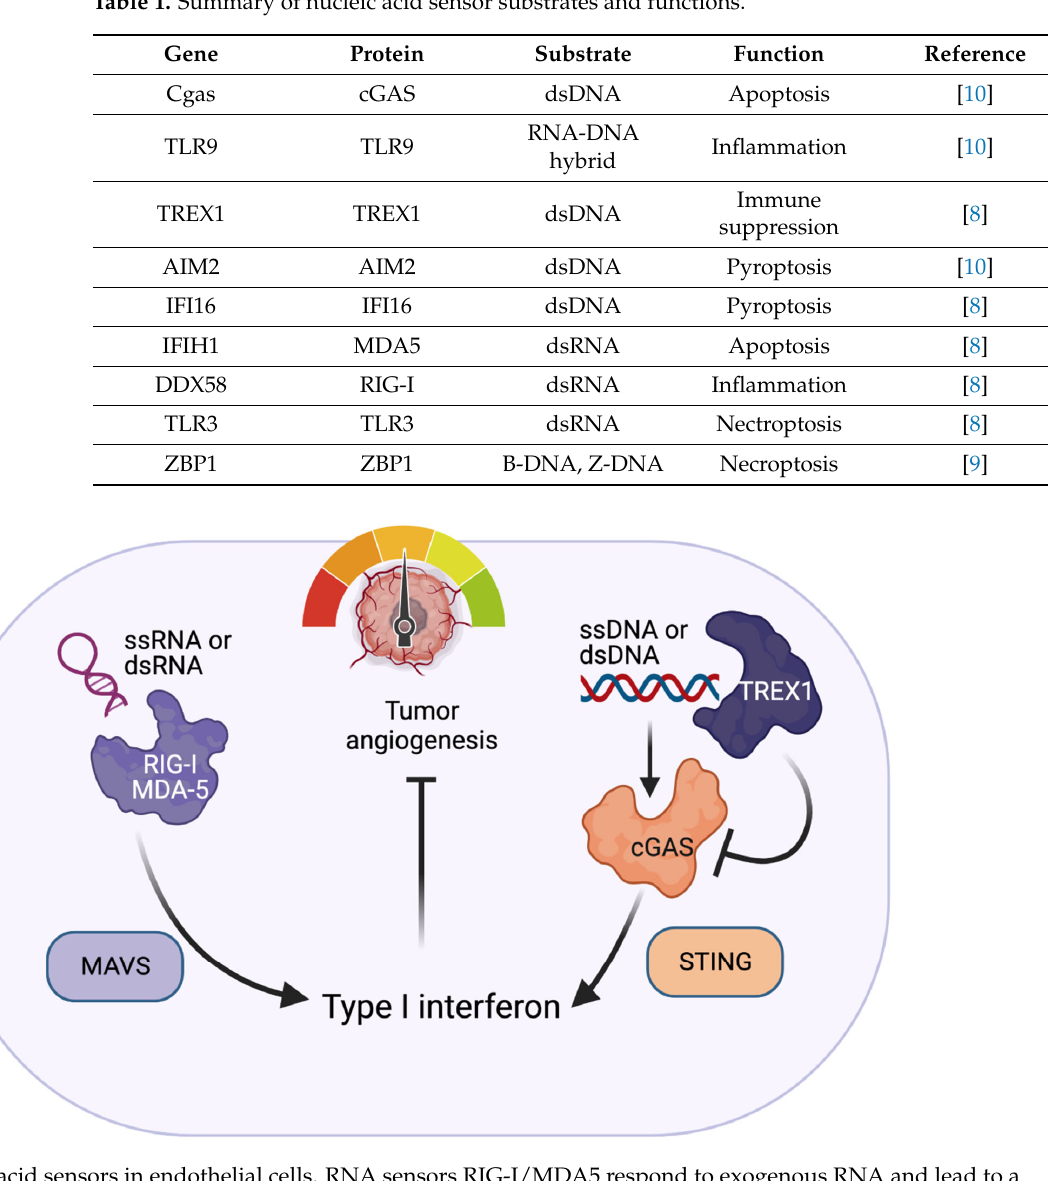
Figure 1. Nucleic acid sensors in endothelial cells. RNA sensors RIG-I/MDA5 respond to exogenous RNA and lead to a type I interferon response via the MAVS pathway in ECs. Conversely, TREX1 degrades ssDNA or dsDNA in the cytosol, thereby preventing activation of the cGAS-STING pathway that activates type I interferons. Activation of the RIG-I pathway or inhibition of the TREX1 pathway will inhibit tumor angiogenesis by upregulating interferon responses.